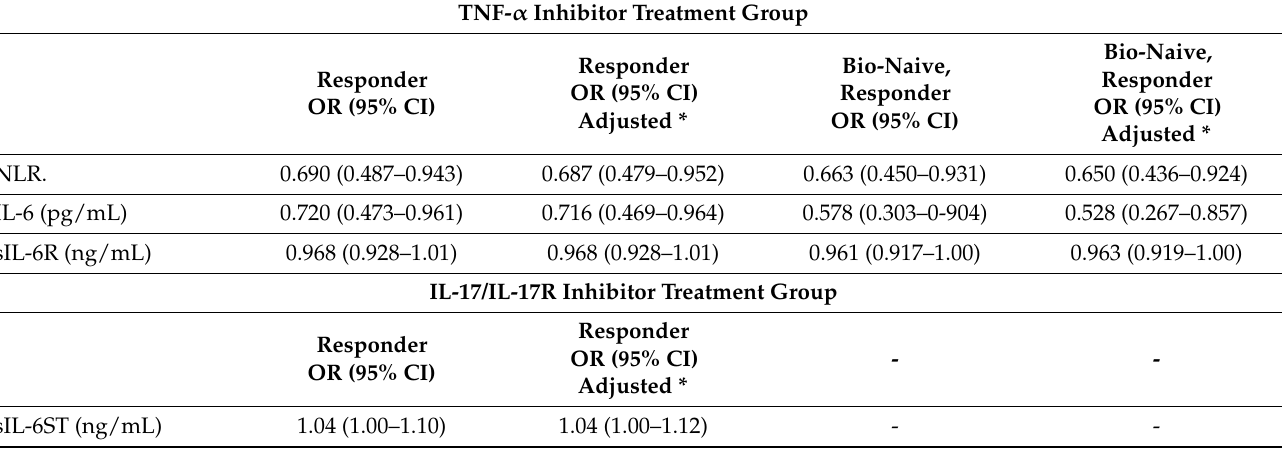
Table 2. Results of logistic regression analysis.